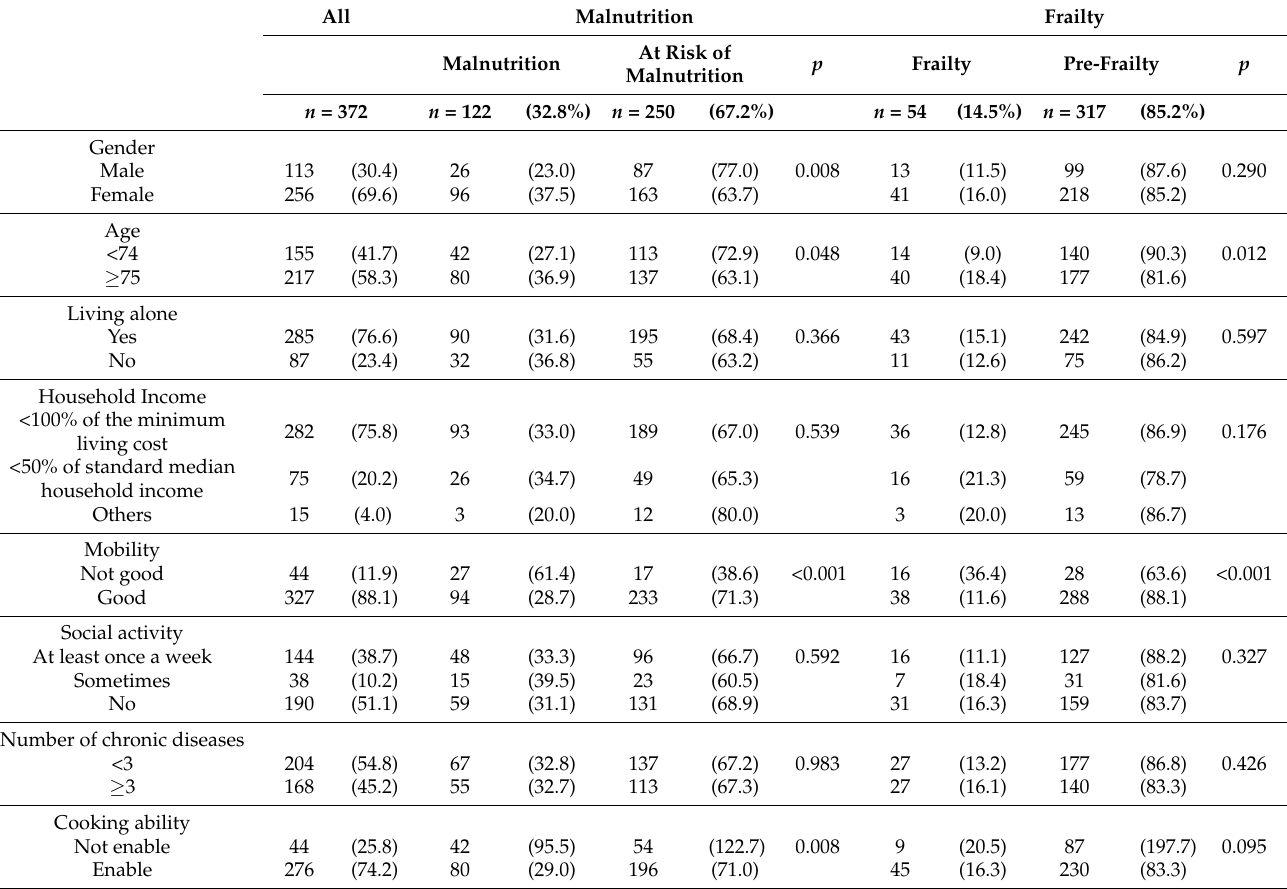
Table 1. Distribution of malnutrition and frailty in study